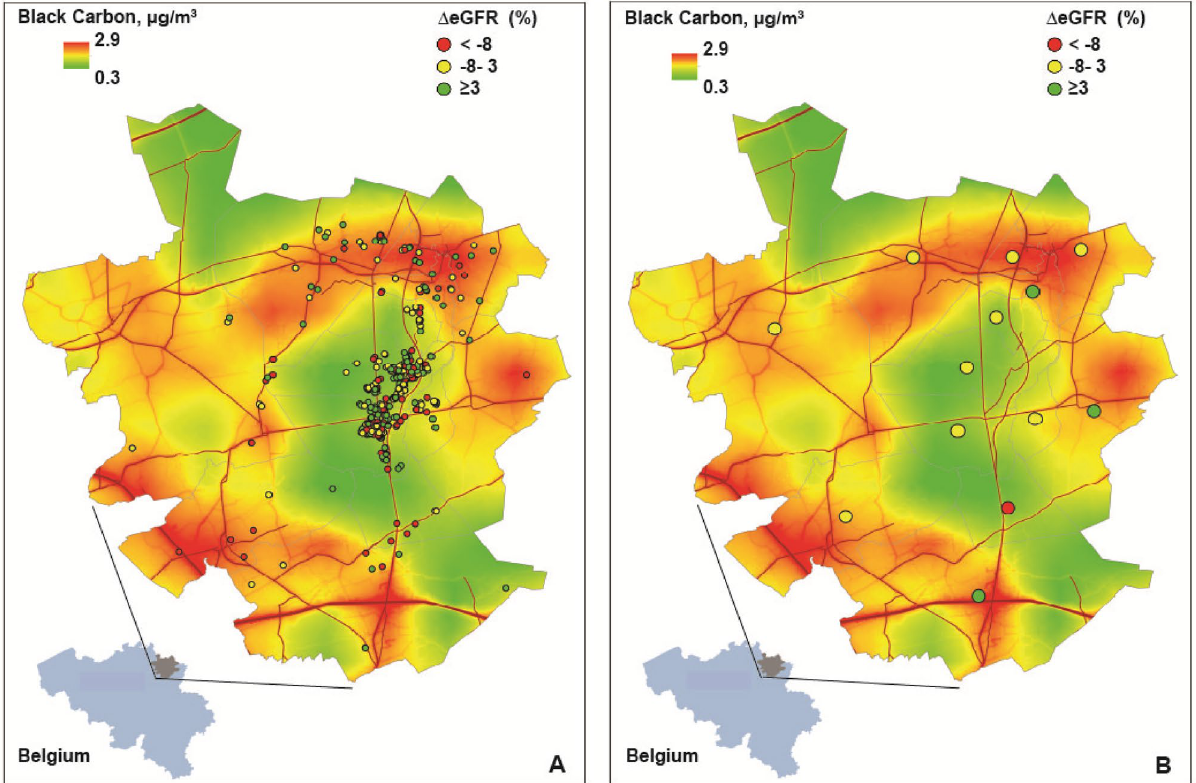
Figure 1. Geographical associations of the multivariable-adjusted percent change in the glomerular filtration rate estimated from serum creatinine (ΔeGFR) at the individual level ( A ) or aggregated per municipality ( B ) with black carbon air pollution contours. Grey lines indicate borders of municipalities. Red lines represent the air pollution contours of major roads. The Spearman rank correlation coefficients between percent change in eGFR and the exposure to BC were -0.016 ( P = 0.68) and 0.200 ( P = 0.52) in the individual and aggregated data,